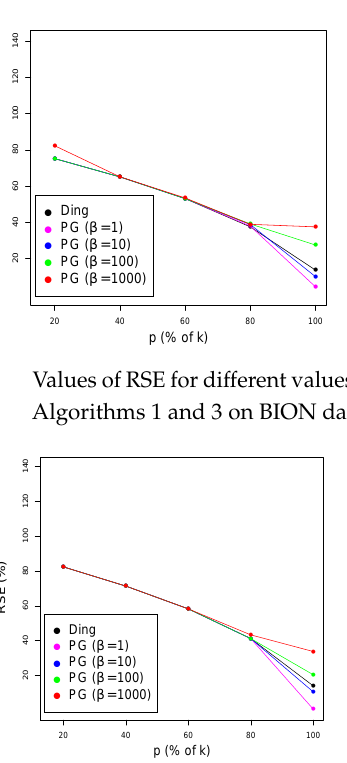
Values of RSE for different values of β obtained by Algorithms 1 and 2 in BION data with n = 500